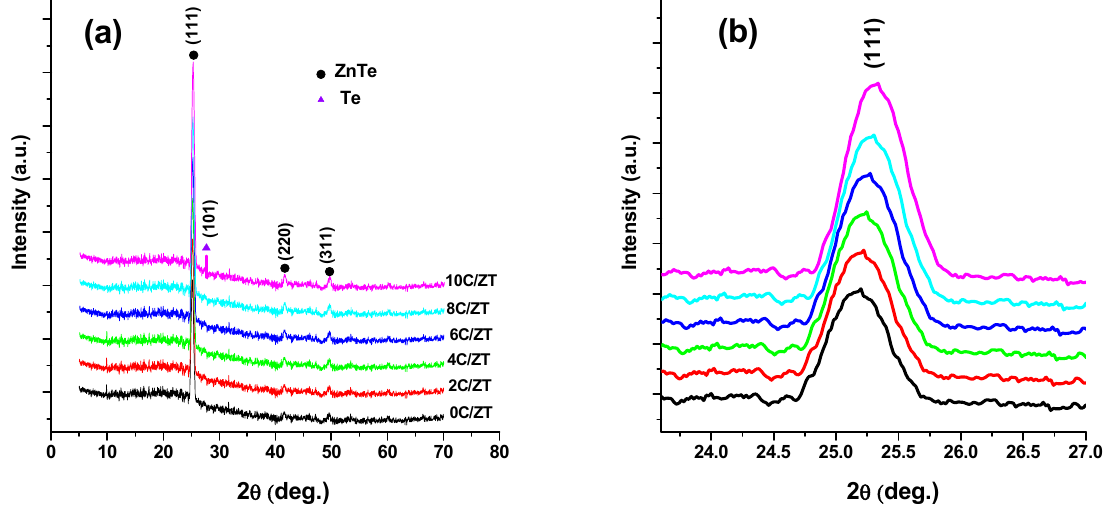
Figure 3. ( a ) XRD of ZnTe:Cu thin films, ( b ) amplification of XRD peaks with index (111).